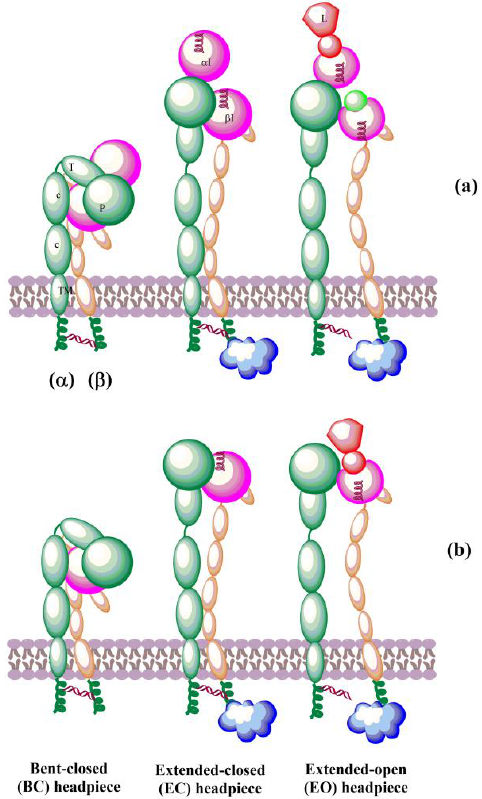
Figure 5. Schematic representation of domain architecture during activation of integrins that ( a ) contain or ( b ) lack an I domain. L = ligand.